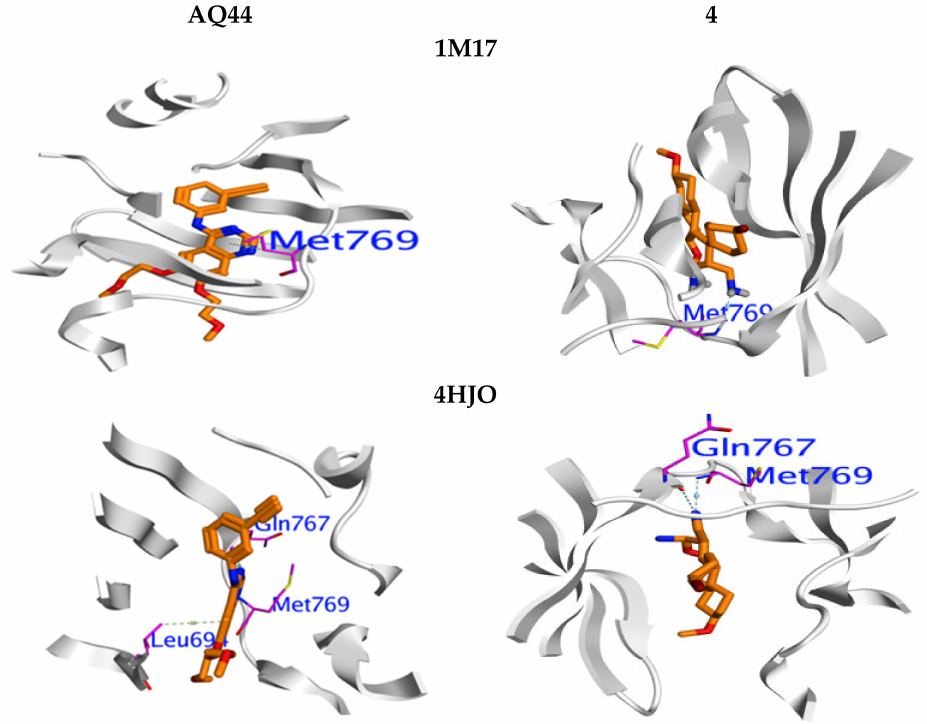
Figure 7. Binding manner for compound 4 over 1M17 and 4HJO compared to co-crystal erlotinib (AQ44) as the reference